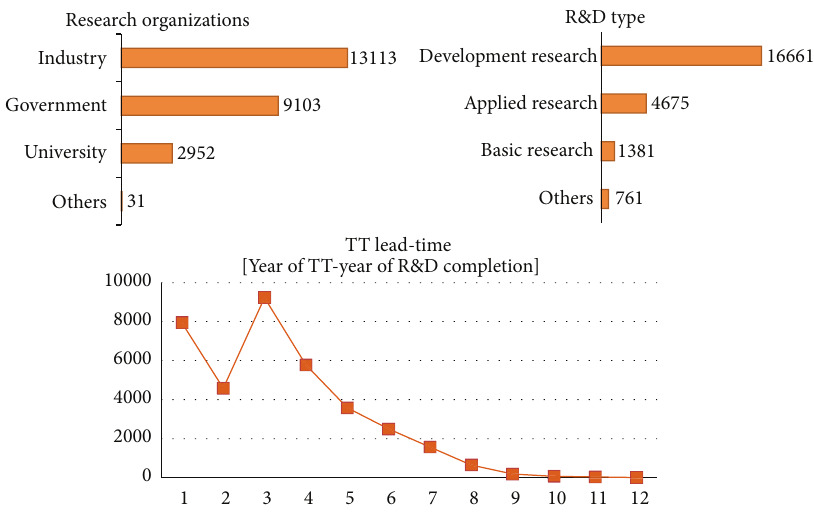
Figure 3: The outcomes of the technology transfer (TT) of the overall national R&D